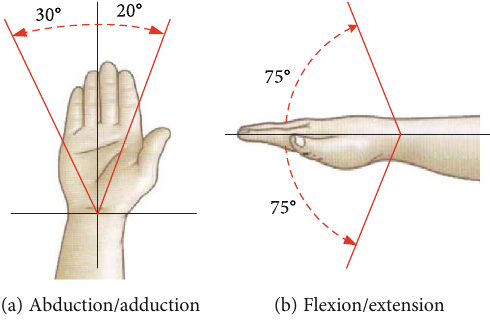
Figure 1: Freedom of movement of the wrist joint.